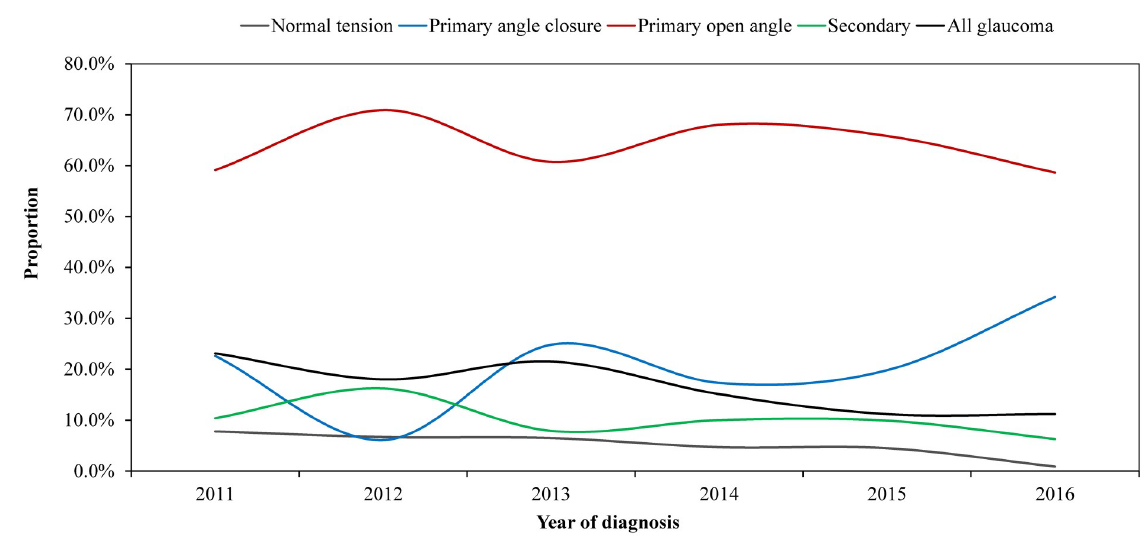
Fig 2. Percentage distribution of glaucoma type by year of diagnosis.